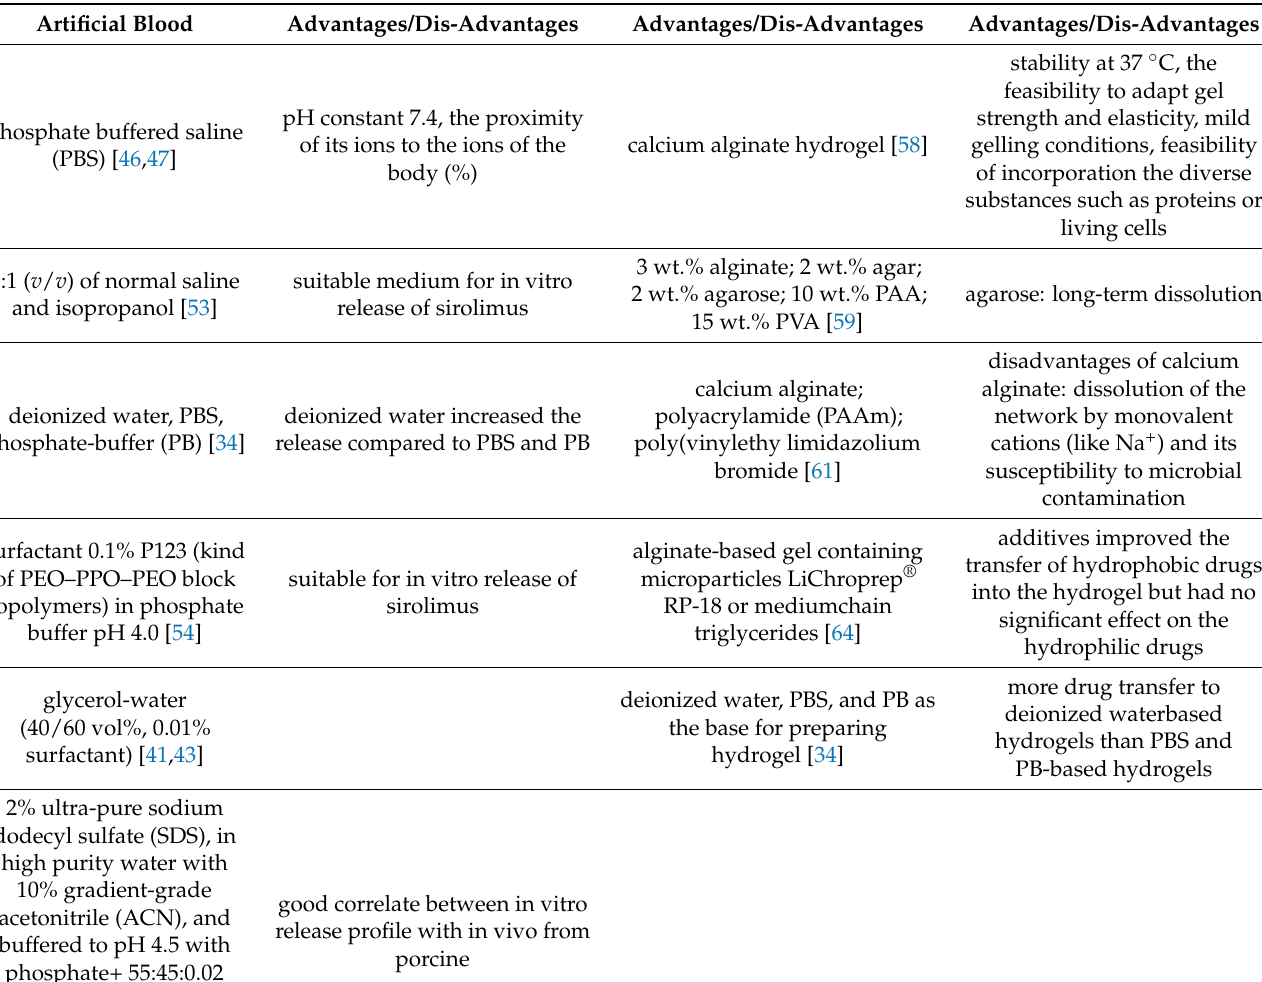
Table 1. Comparison of the artificial blood and tissue used in different in vitro